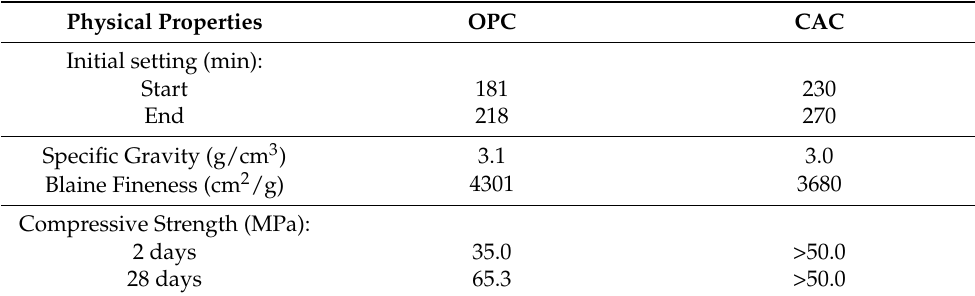
Table 2. Physical properties of